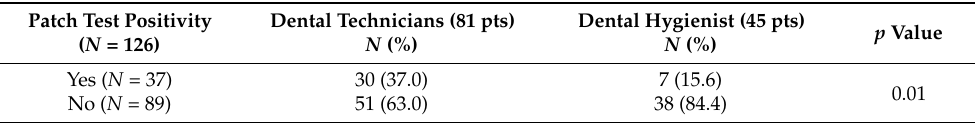
Table 2. Methacrylate series (FIRMA) patch test positivity for at least one allergen in dental technician and dental hygienist